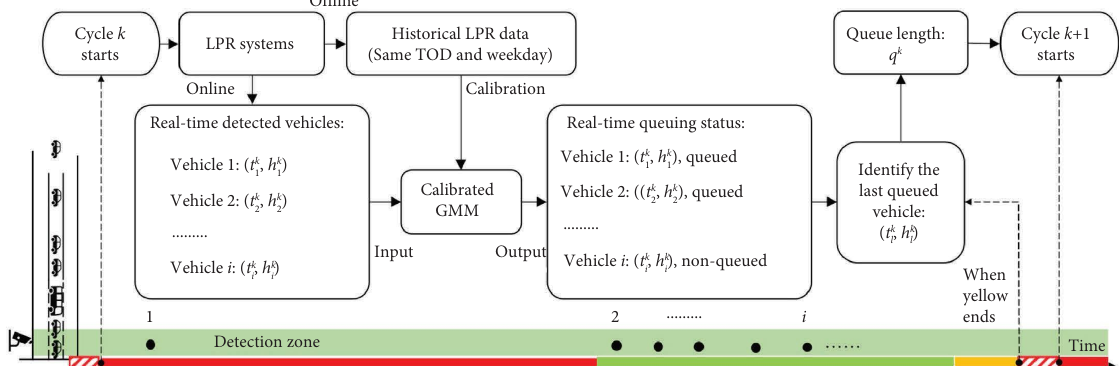
Figure 2: Te fow chart depicting the real-time application of the proposed method.